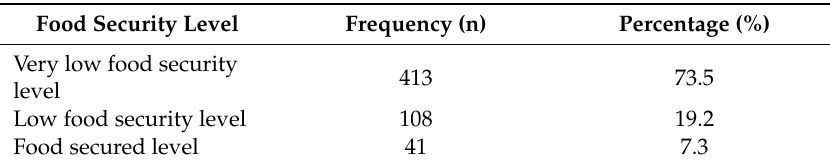
Table 2. Food security level of respondents (n =